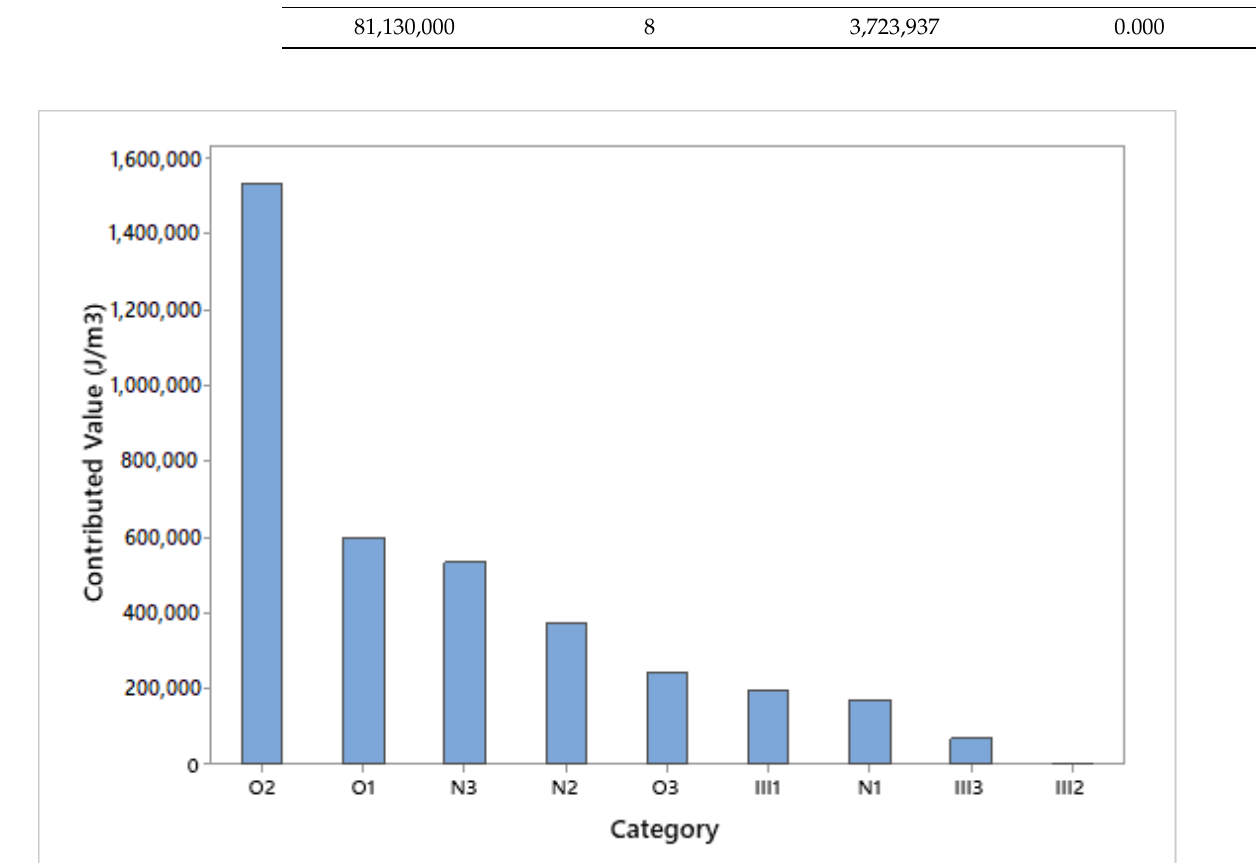
Table 4. The results of the chi-squared test for samples.